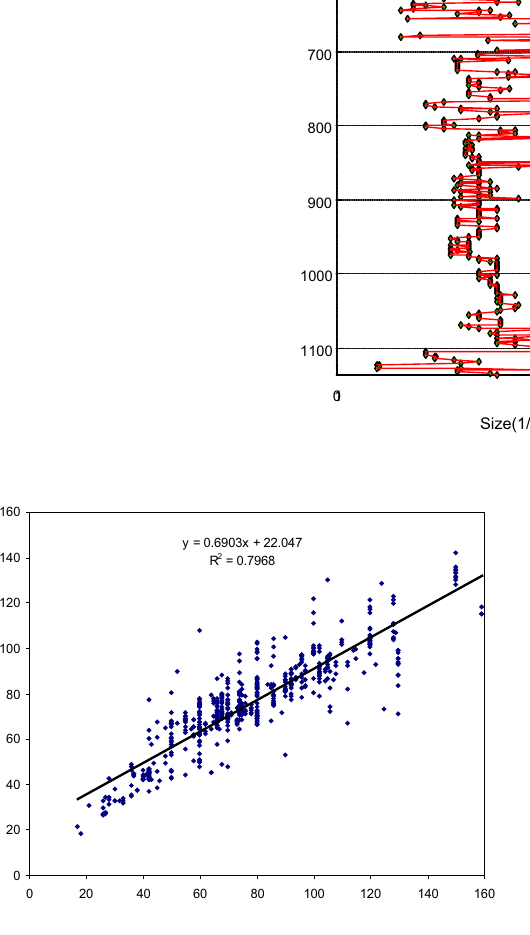
Fig. 14 Actual versus predicted choke size for RBF model training (spread = 0.1)